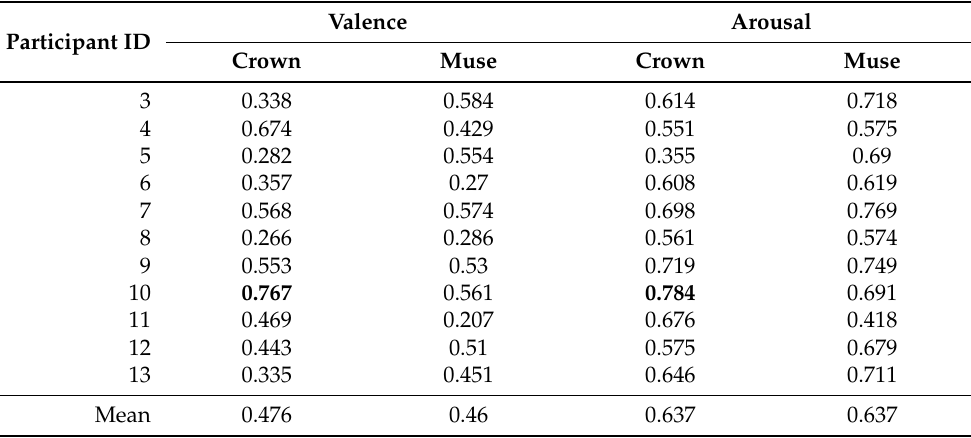
Table 6. Mean F1-Scores for Valence and Arousal recognition of Dataset II, relayed per participant and device. Obtained using ARF (with four trees), a window length of 1 s, and progressive delayed validation with a label delay of 86 s. The bold values represent the highest scores, and the last row shows the mean F1-Score of all